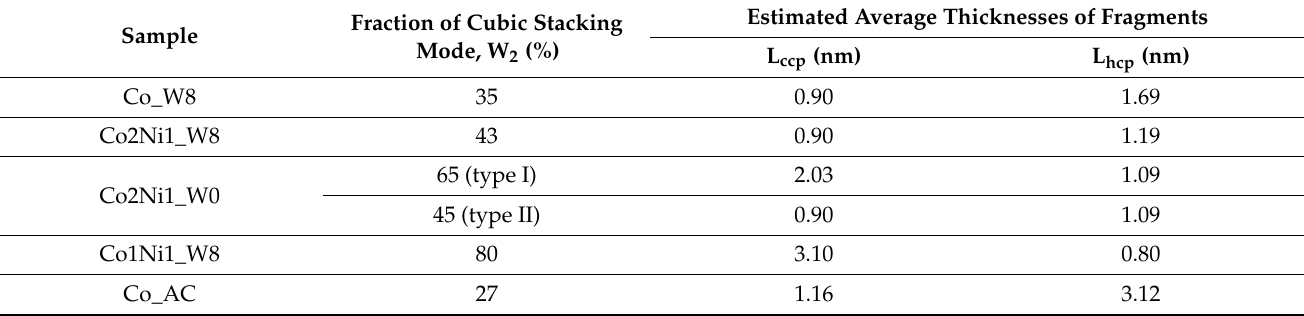
Table 3. The fraction of the cubic stacking mode (W2) and the estimated average thickness of fragments with a ccp and hcp